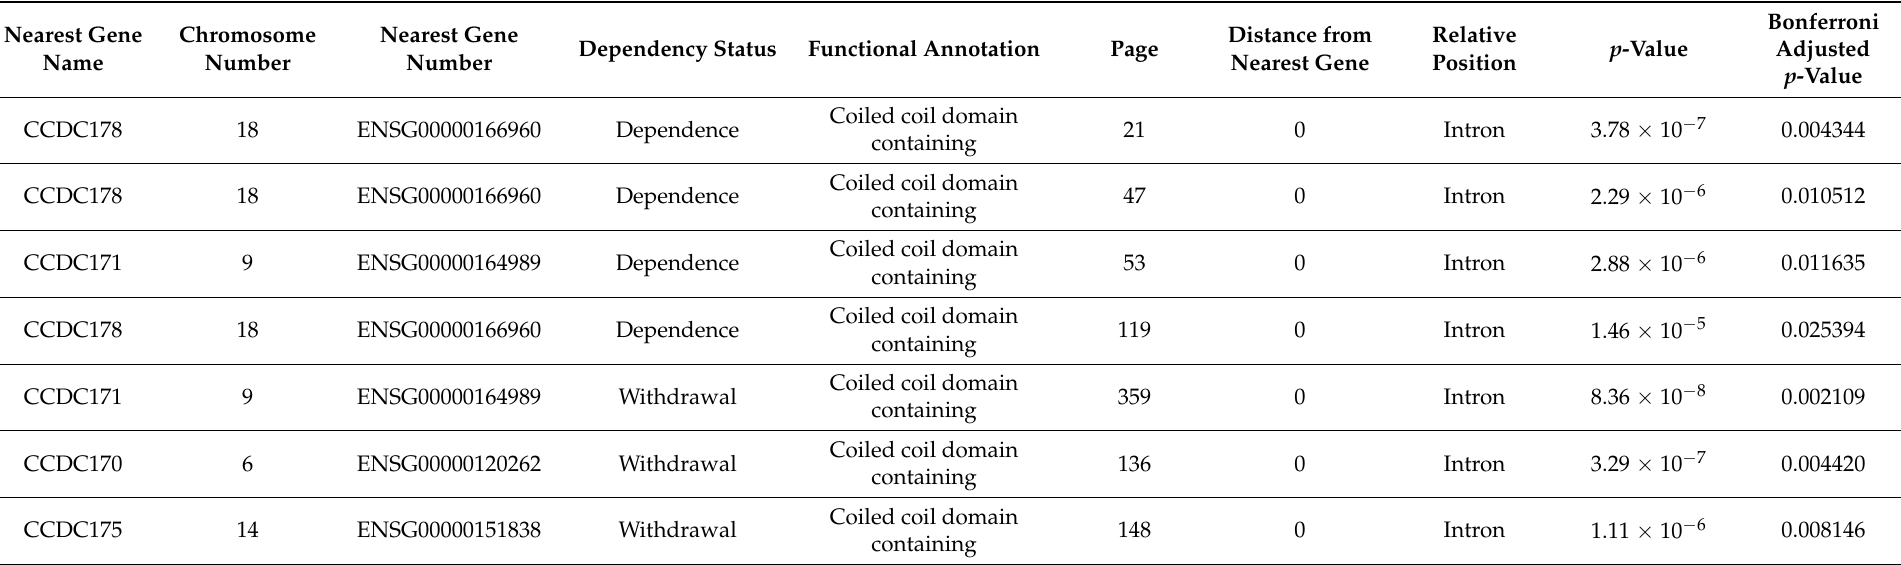
Table 19. EWAS Hits from Schrott Dataset for Significantly Differentially Methylated Regions for. Major Genes of Nephrogenesis